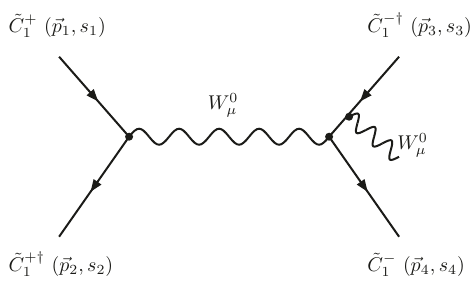
Figure 19. Example of a Feynman diagram for 2 ! 3 inelastic scattering involving the